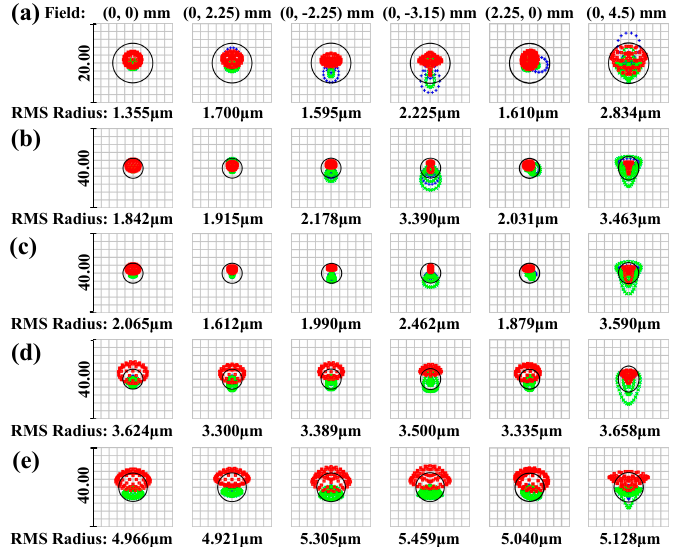
Figure 4. Spot diagrams of different magnifications: ( a ) 6×, ( b ) 10×, ( c ) 16×, ( d ) 25×, and ( e ) 40×. RMS: root-mean-square. Appl. Sci. 2020 , 10 , x FOR PEER REVIEW